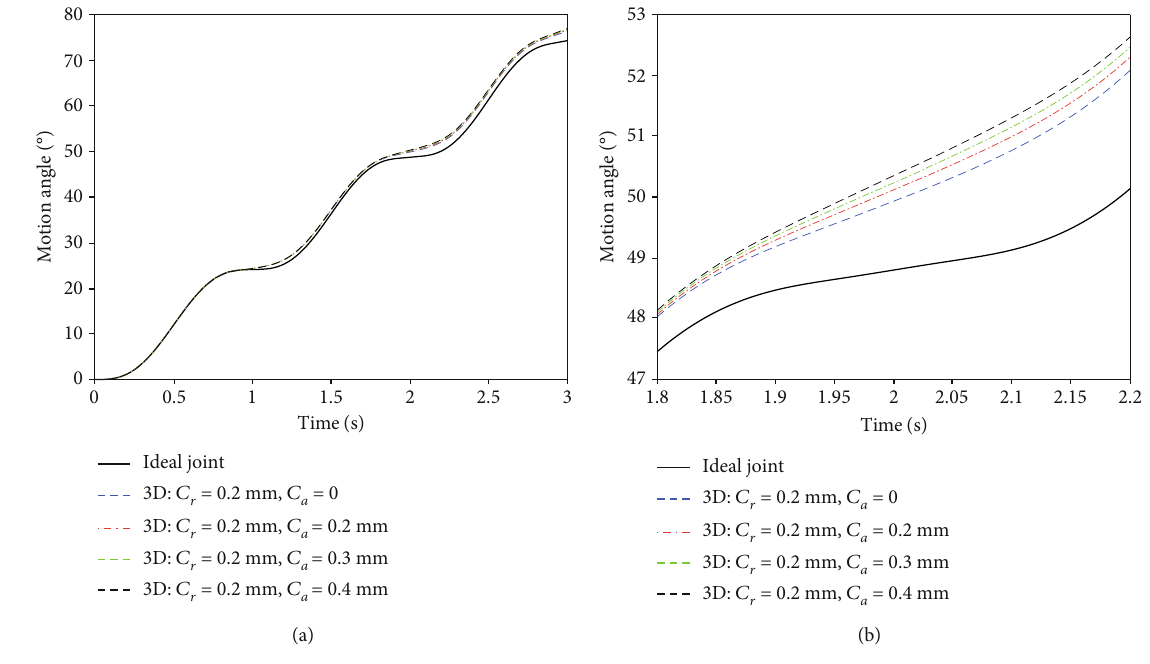
Figure 11: Motion angular displacement of the antenna: (a) motion angle; (b) partial zoom.